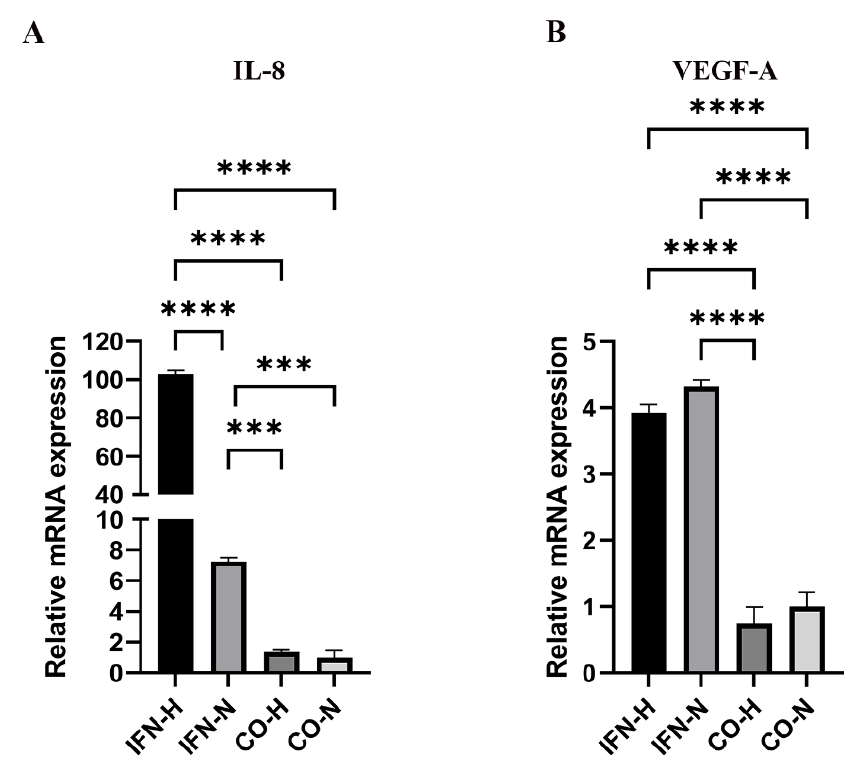
Figure 3. Expression of angiogenesis-related genes by iMSCs pre-conditioned with IFN- γ under hypoxic and normoxic conditions. Gene expression levels of IL-8 ( A ) and VEGF-A ( B ) in iMSCs were quantified using a Thermo Fisher Scientific PCR instrument, and ratios of the target mRNA copy numbers related to copy numbers of the housekeeping gene (GAPDH) were calculated. Gene ex- pressions mean values ± SEM in iMSCs from the IFN-H, IFN-N, CO-H, and CO-N groups displayed as x-fold induction values relative to the CO-N (control normoxic) group. Data were collected from three independent experiments (*** p < 0.001; **** p < 0.0001).